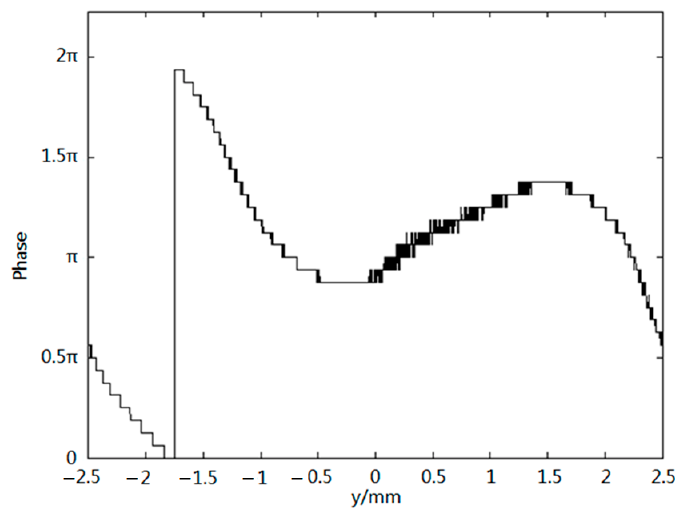
Figure 9. The DOE phase distribution along Y axis.